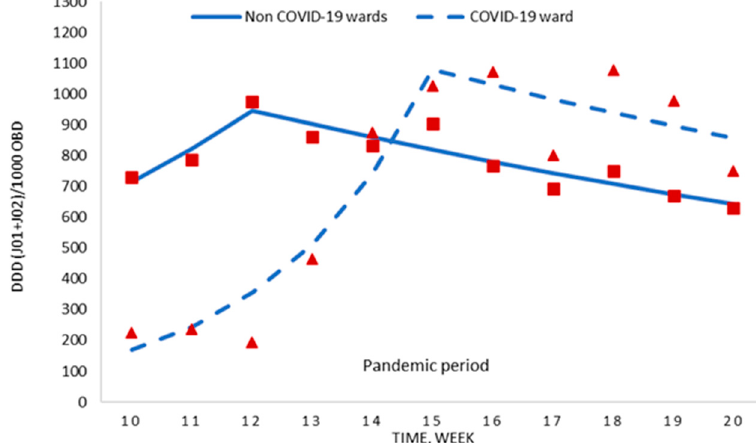
Figure 3. Segmented regression analysis of antimicrobial consumption for the COVID-19 ward and the hospital without the COVID-19 ward during the pandemic period. Red boxes (non COVID-19 wards) and red triangles (COVID-19 ward) represent the observed value for DDD/1000 OBD, and solid lines (non COVID-19 wards) and dashed lines (COVID-19 ward) are the modelled regression trend segments characterised by the joinpoint regression analysis. DDD, defined daily doses; ATC group J01 (antibacterials for systemic use) and J02 (antifungals); OBD, occupied bed days.